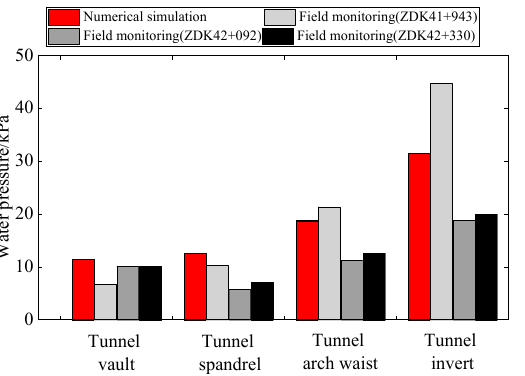
Figure 6. The comparison diagram of external water pressure of initial support of the sub-sea tun ‐ nel.